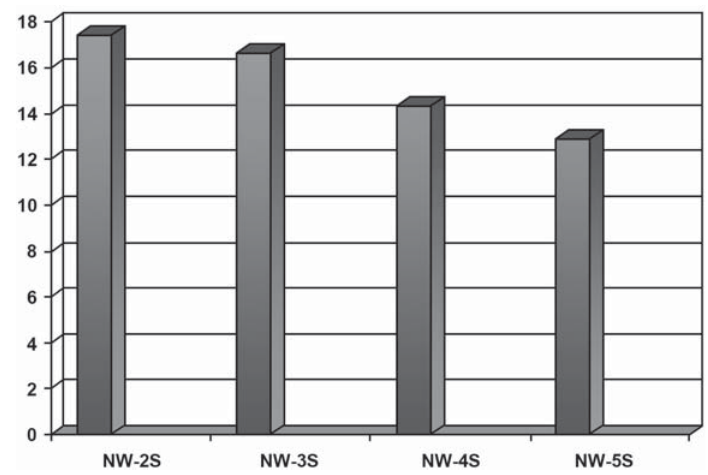
Figure 2- Comparative measurements between the numbers of syllables of